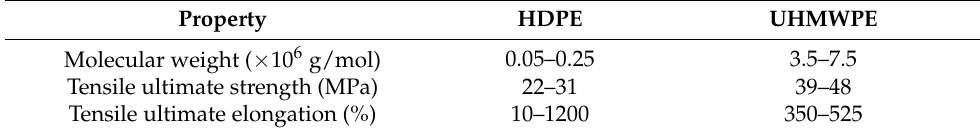
Table 2. Physical properties of HDPE and UHMWPE